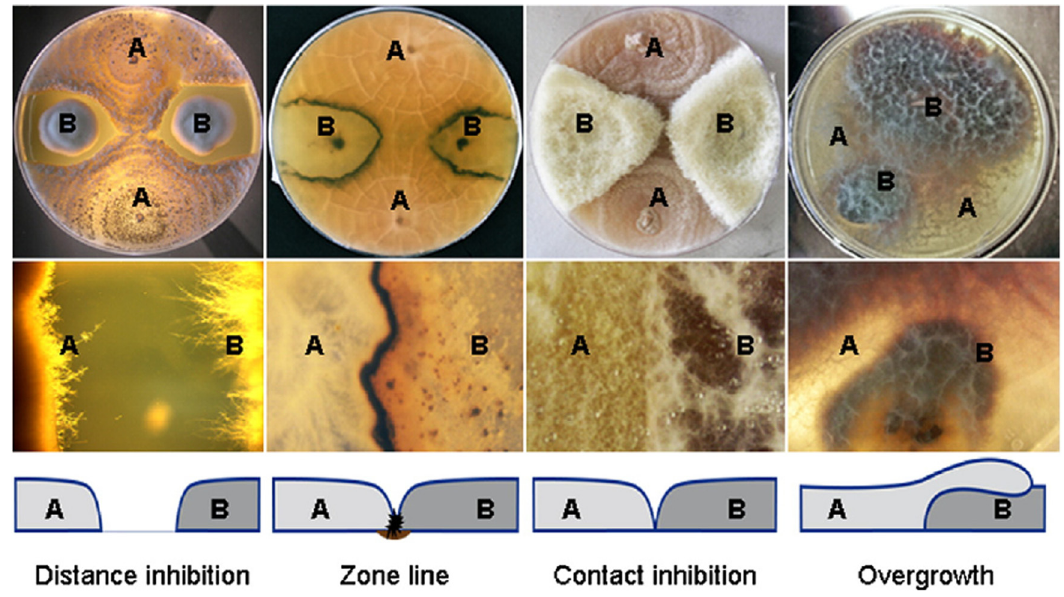
Figure 3: Four major types ( distance inhibition, zone lines, contact inhibition and overgrowth ) of mixed culture fungus performed on solid agar plates [ 65 ] .